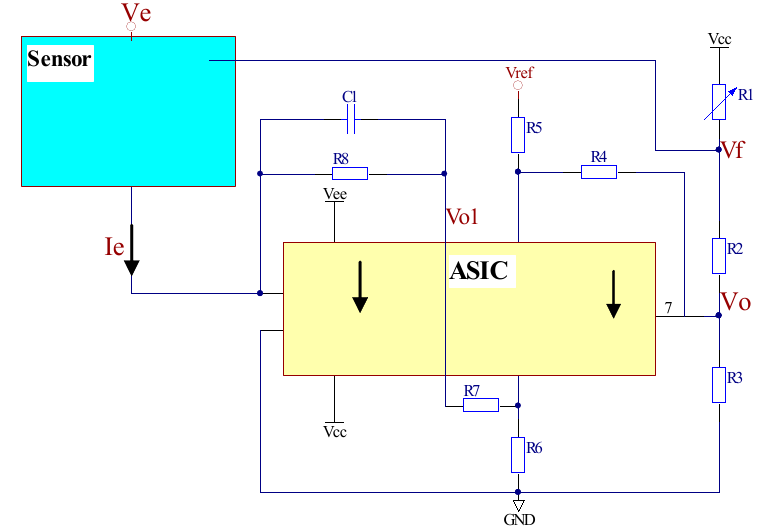
Figure 9. Schematic of the interface circuit of the vacuum microelectronic accelerometer.